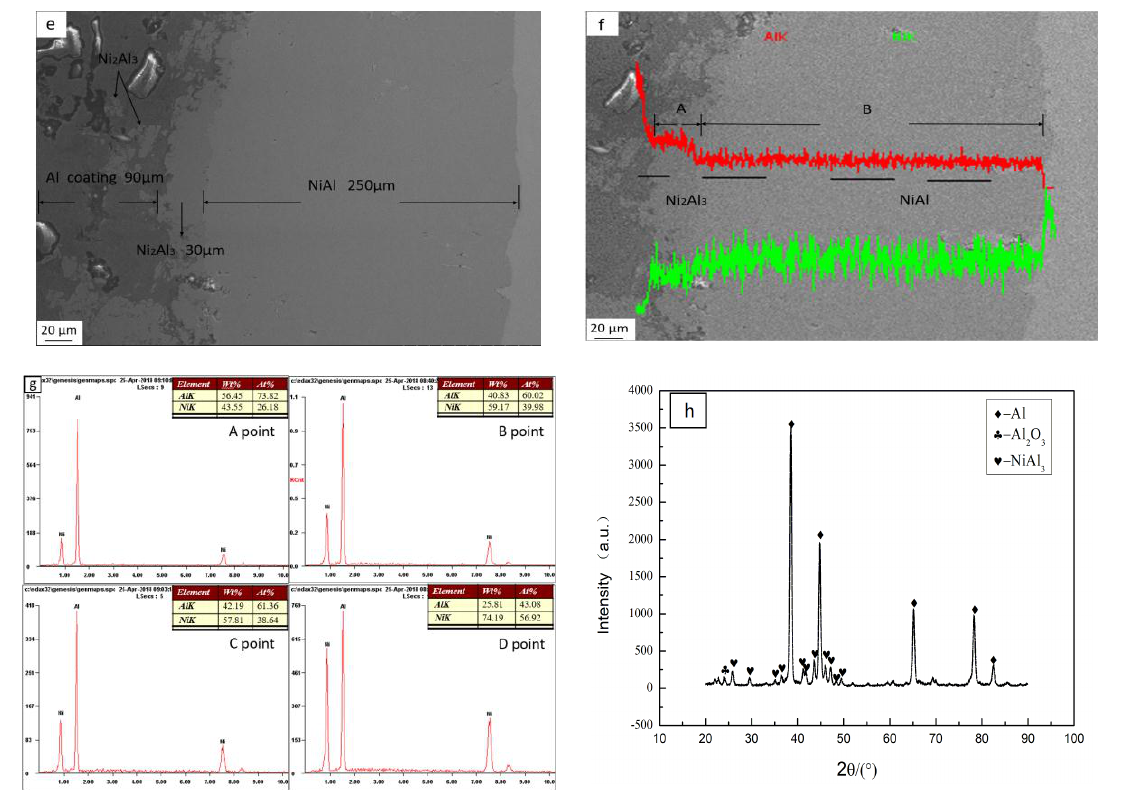
Figure 1. ( a ) Cross-sectional SEM image of Al coating on the metallurgical Ni piece without heating; ( b – e ) cross-sectional SEM images of Al coating after testing for 2, 5, 10, and 20 h at 973 K; ( f ) concentration profiles of elemental Al and Ni in Figure 1 ( e , g ) EDS results of points A, B, C, and D marked in Figure 1 ( b ). ( h ) XRD pattern of Al coating on the metallurgical Ni piece after testing for 2 h at 973 K.